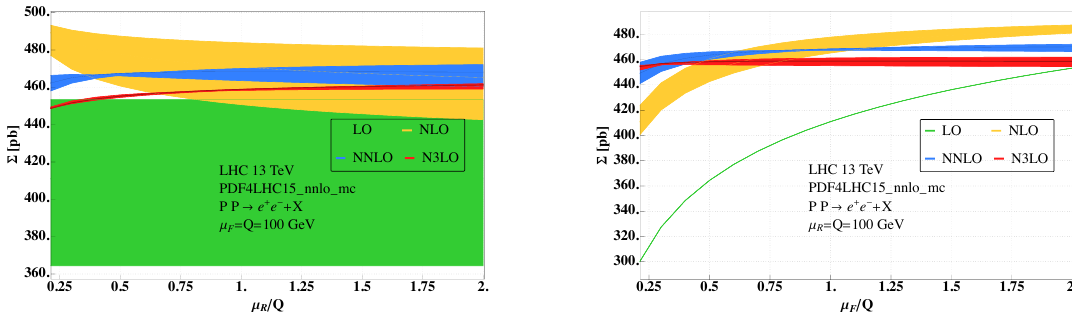
Figure 7. Dependence of the invariant-mass distribution through N 3 LO on one of the two per- turbative scales with the other held fixed. The bands are obtained by varying the other scale by a factor of two around the central scale Q = 100